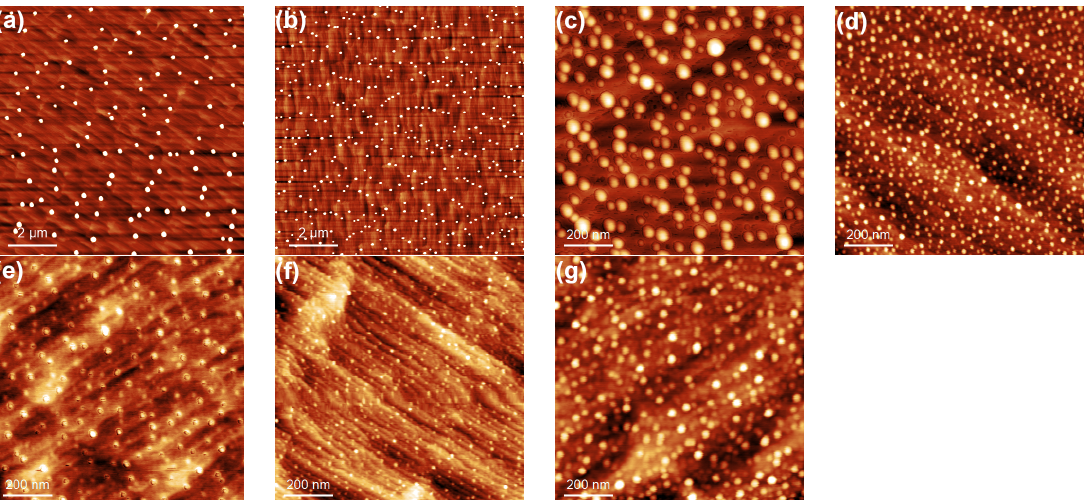
Figure 1. Atomic force microscope (AFM) images of indium islands, obtained by depositing 2 ML of In on GaAs(111)A with 2 ◦ miscut towards ( 112 ) at ( a ) 395 ◦ C (10 × 10 µ m 2 ), ( b ) 370 ◦ C (10 × 10 µ m 2 ), ( c ) 240 ◦ C (1 × 1 µ m 2 ), ( d ) 160 ◦ C (1 × 1 µ m 2 ), ( e ) 80 ◦ C (1 × 1 µ m 2 ), and ( g ) 30 ◦ C (1 × 1 µ m 2 ). ( f ) AFM image of indium islands, obtained by depositing 1 ML of In on GaAs(111)A with 2 ◦ miscut towards ( 112 ) at (a) 80 ◦ C (1 × 1 µ m 2 ).